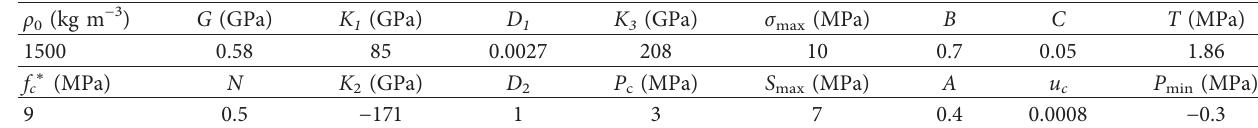
Table 2: HJC model parameters of the coal-rock.